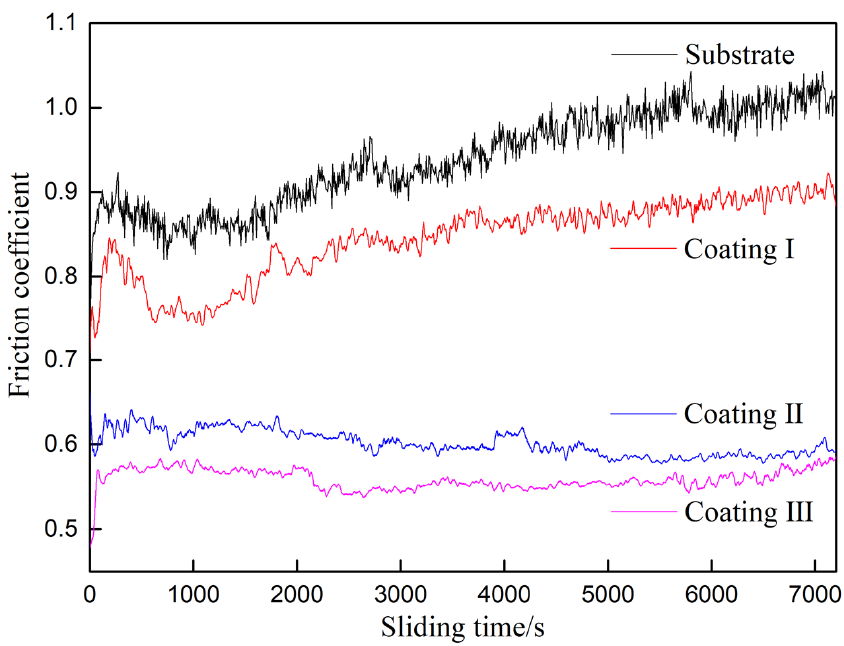
Figure 5. The relationship between friction coefficient and sliding time of the substrate and the coatings subject to friction in air.